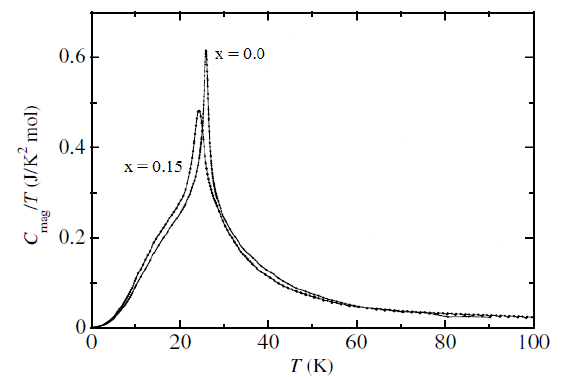
Al O for: x = 0 (a) and x = 0.15 (b). 1−x x 2